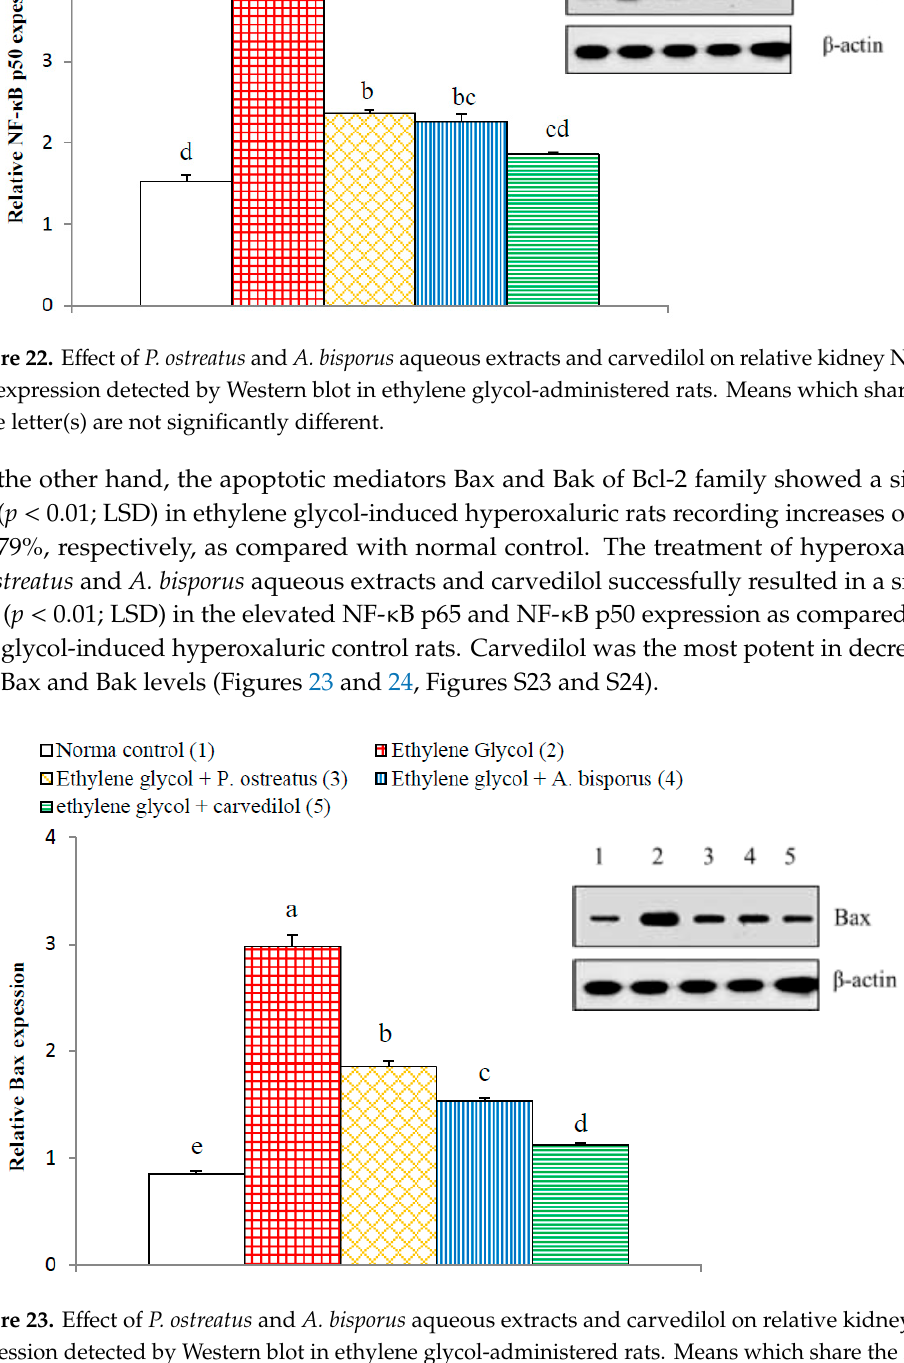
Figure 23. Effect of P. ostreatus and A. bisporus aqueous extracts and carvedilol on relative kidney Bax expression detected by Western blot in ethylene glycol-administered rats. Means which share the same letter(s) are not significantly different.